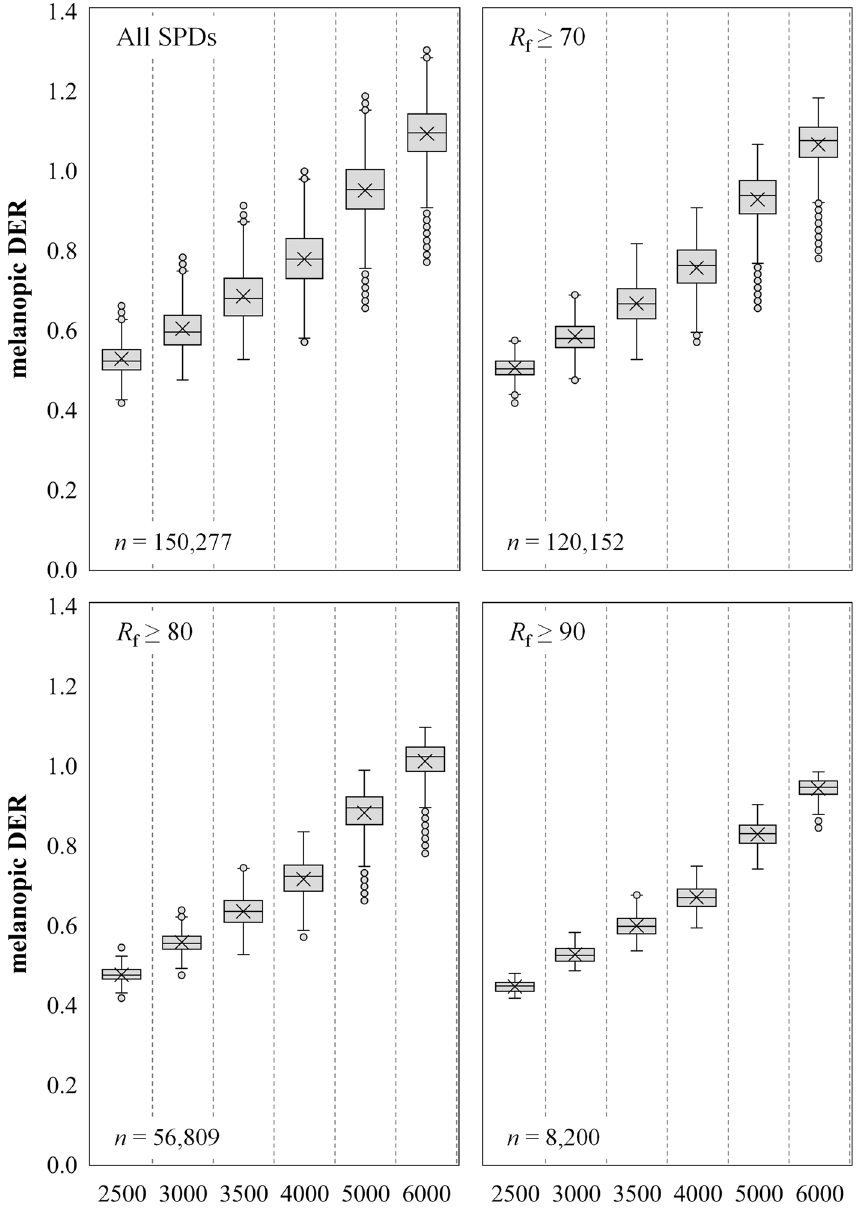
Figure 6. Boxplots of melanopic daylight efficacy ratio (mel-DER) as a function of nominal CCT. (Top left) All SPDs for the “Filtered” dataset. (Top right) The “Filtered” dataset further filtered for R f ≥ 70. (Bottom left) The “Filtered” dataset further filtered for R f ≥ 80. (Bottom right) The “Filtered” dataset further filtered for R f ≥ 90. In all cases, the average mel-DER increases as CCT increases, but so too does the achievable mel-DER range. As the average fidelity floor is raised (i.e., from R f ≥ 70 to R f ≥ 80 to R f ≥ 90), the average, maximum, and achievable range of mel-DER